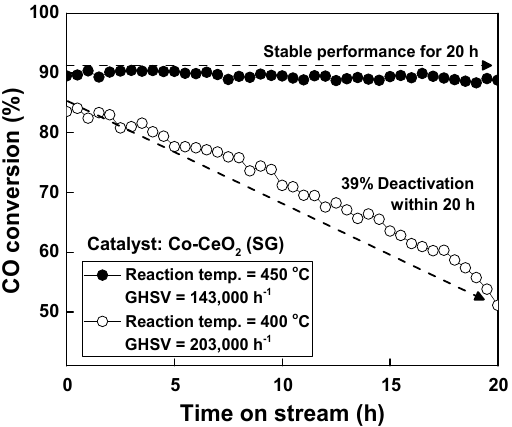
Figure 7. CO conversion with time on stream over Co–CeO 2 (SG) catalysts (H 2 O / (CH 4 + CO + CO 2 ) = 2.0; T = 400 and 450 °C; GHSV = 203,000 and 143,000 h - 1 ).